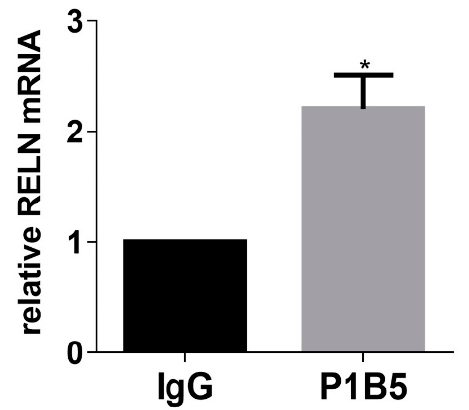
Figure 2. Treatment of MDA-MB-231 cells with a function-blocking antibody against α 3 β 1 increases RELN mRNA expression. qRT-PCR was performed to compare RELN mRNA in MDA-MB-231 cells plated on laminin-332-rich matrix and treated with the α 3 β 1-blocking antibody, P1B5, or with IgG as a control. Data are average +/ − SEM, n = 3; * p ≤ 0.05, unpaired t -test.